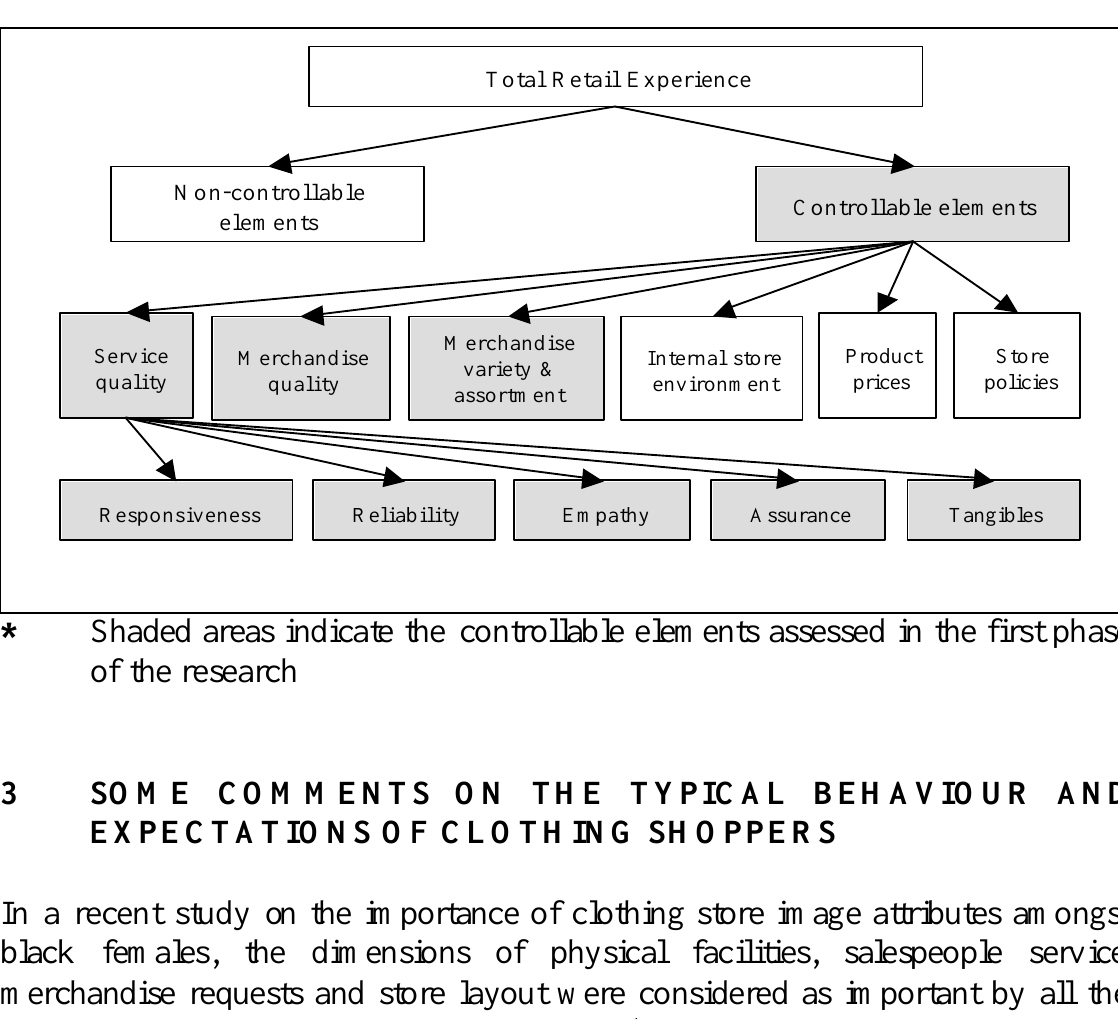
Figure 1 Schematic presentation of the theoretical structure of the